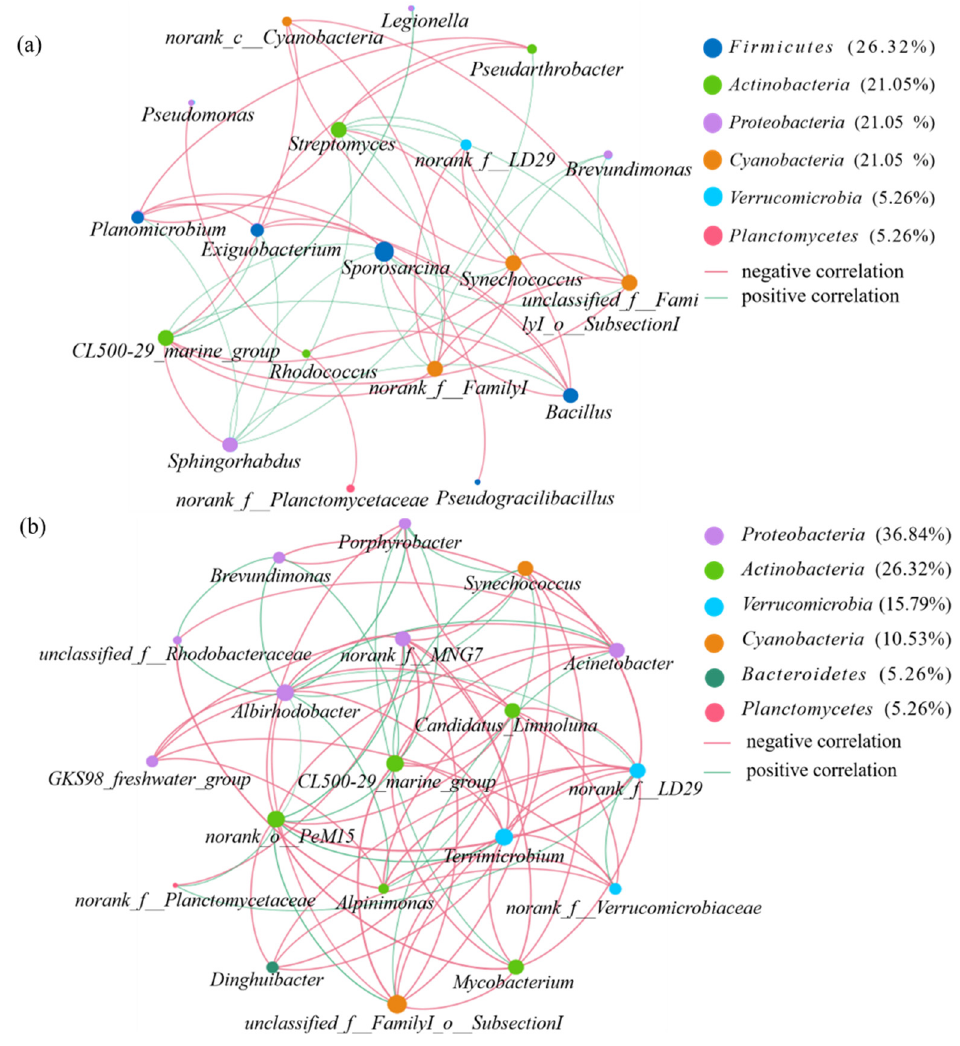
Figure 6. Co-occurrence networks for microbial communities in May. Jun. and Jul. ( a ); in Aug. and Sep. ( b ).